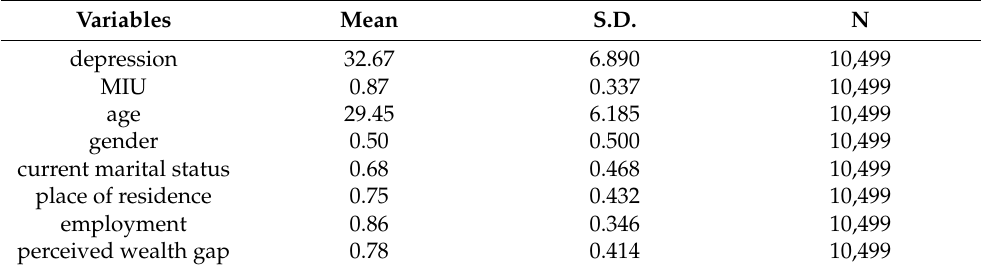
Table 1. Descriptive